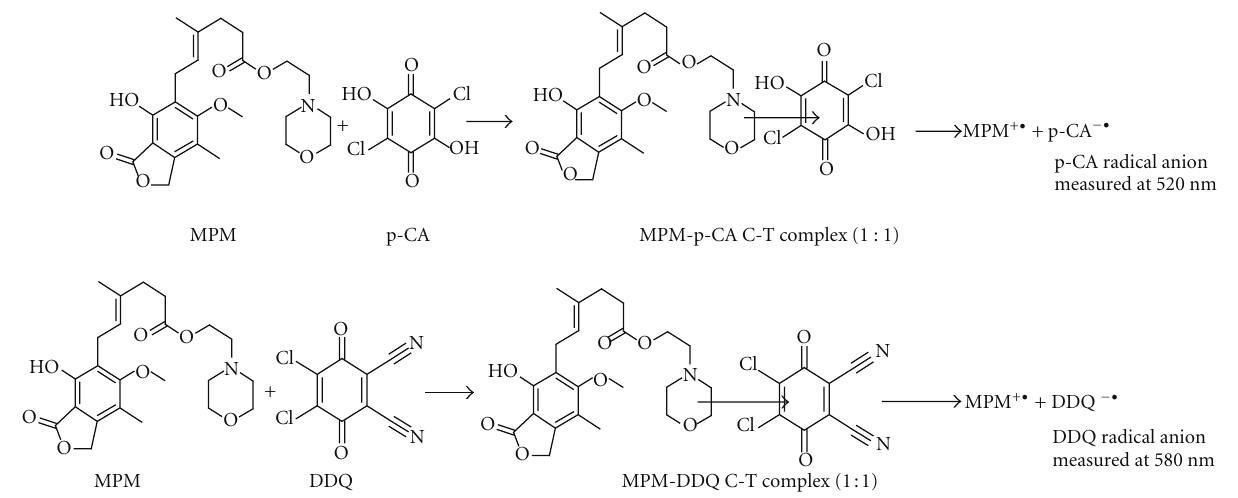
Scheme 1: Proposed reaction path way for the formation of C-T complex between MPM and